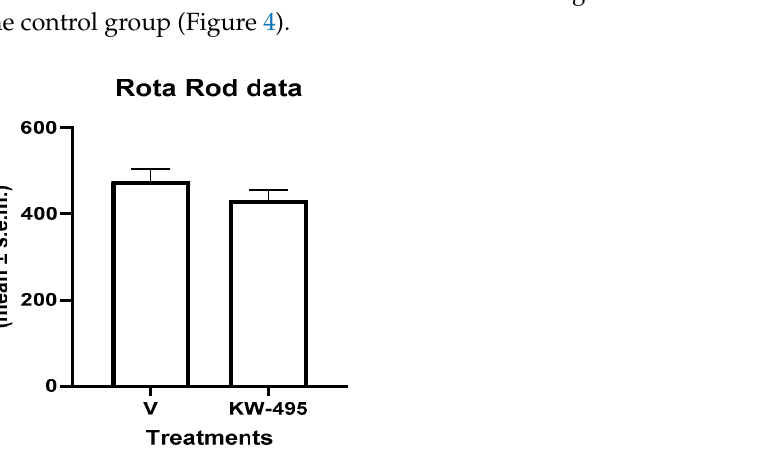
Figure 4. Effects of KW-495 (6.2 nmol/animal, i.t.) on falling latencies of mice in the rotarod test, n = 7–8 mice for each experimental group.